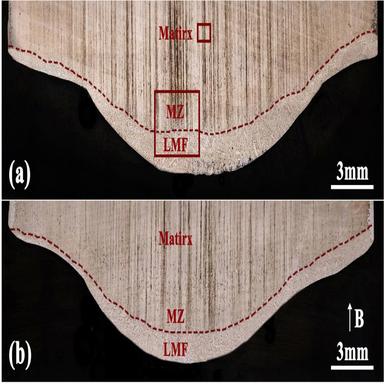
Macrostructures of the longitudinal section of the electrode tip under different experimental parameters, (a) 700A without ASMF, (b) 700A with ASMF respectively.